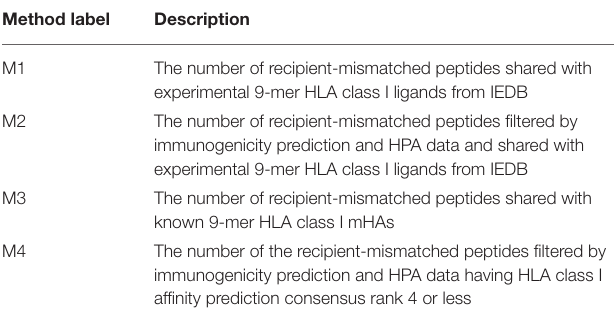
TABLE 2 | Computational approaches for estimating HSCT